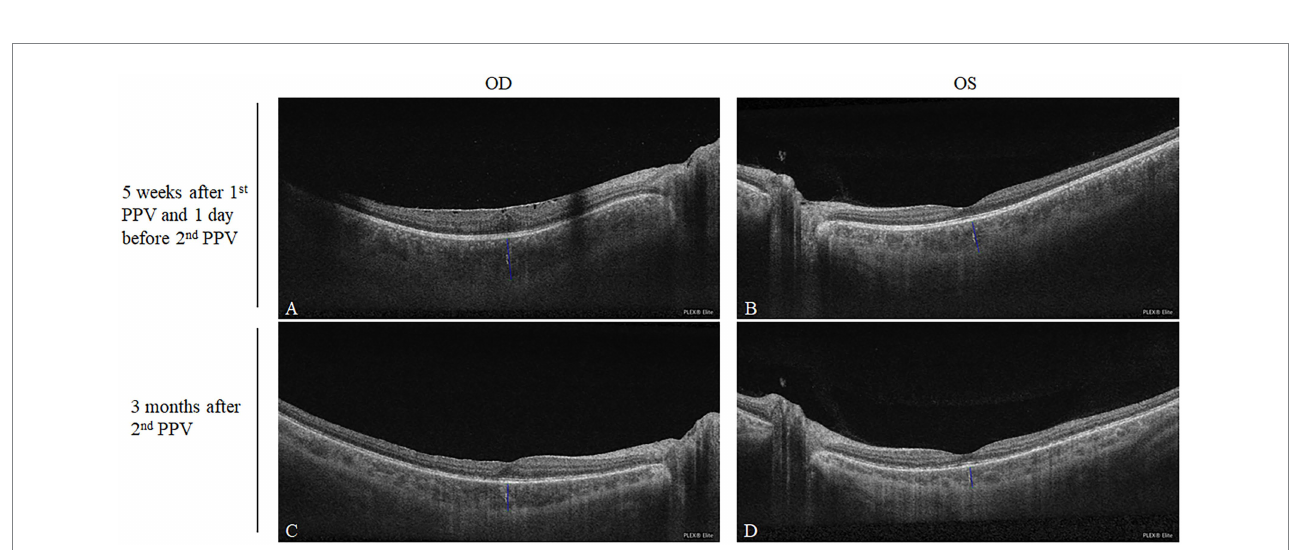
FIGURE 2 Comparison of the subfoveal choroidal thicknesses after the first PPV and after corticosteroid treatment. Five weeks after the first PPV, the subfoveal choroidal thicknesses of the right and left eyes were 572 and 458 μ m, respectively (A,B) . Three months after the second PPV being treated with oral corticosteroid, the subfoveal choroidal thicknesses of the right and left eyes decreased to 369 and 290 μ m, respectively (C,D)